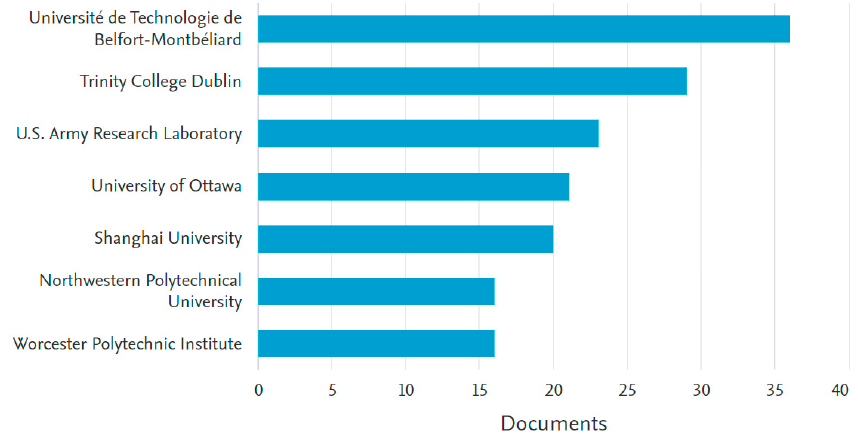
Figure 16. Number of documents by affiliation.